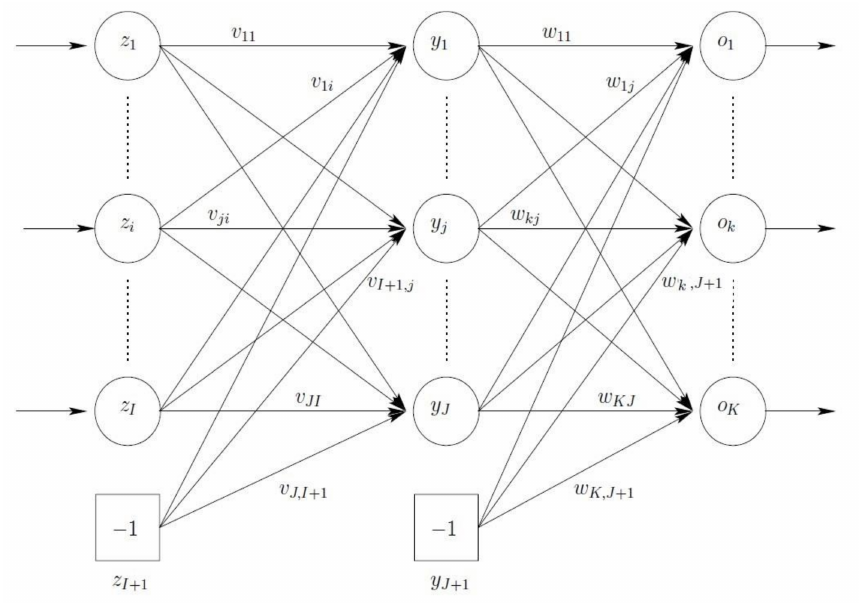
Figure 1. A feedforward neural network